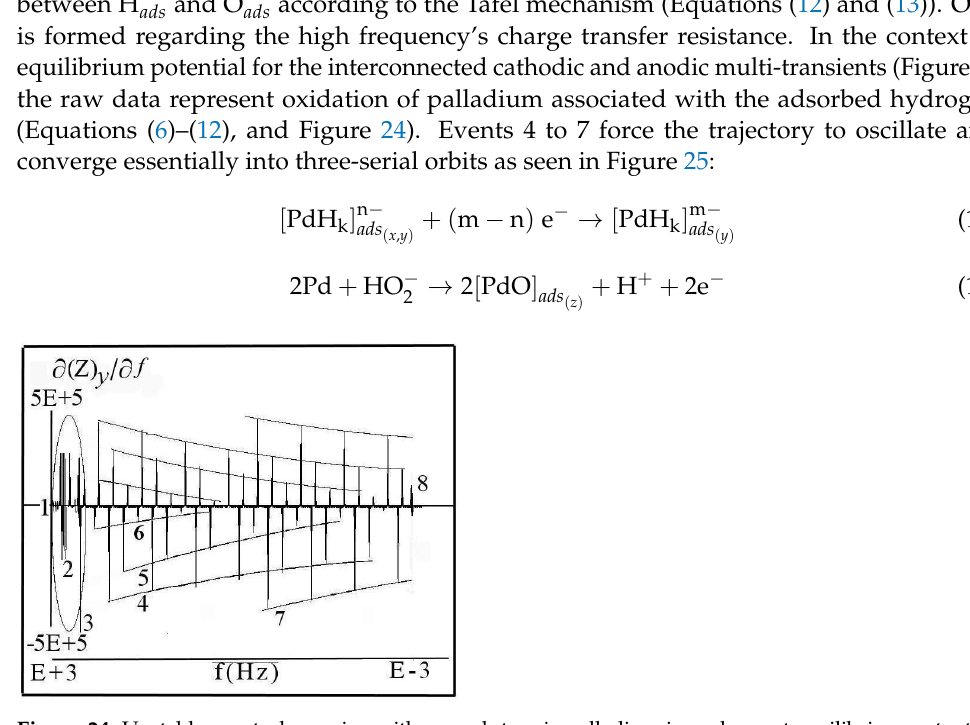
Figure 24. Unstable events decreasing with several steps in palladium impedance at equilibrium potential.